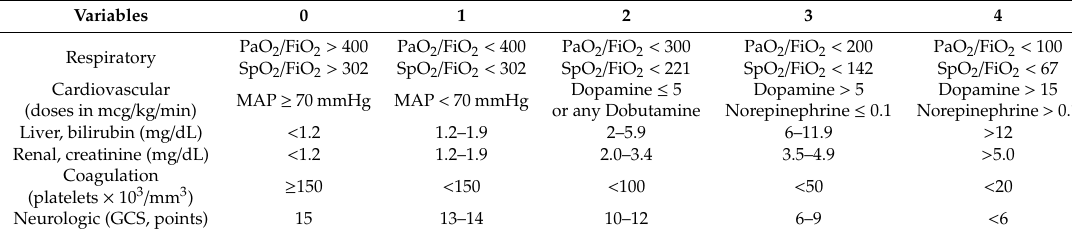
Table 2. Sequential organ failure assessment score